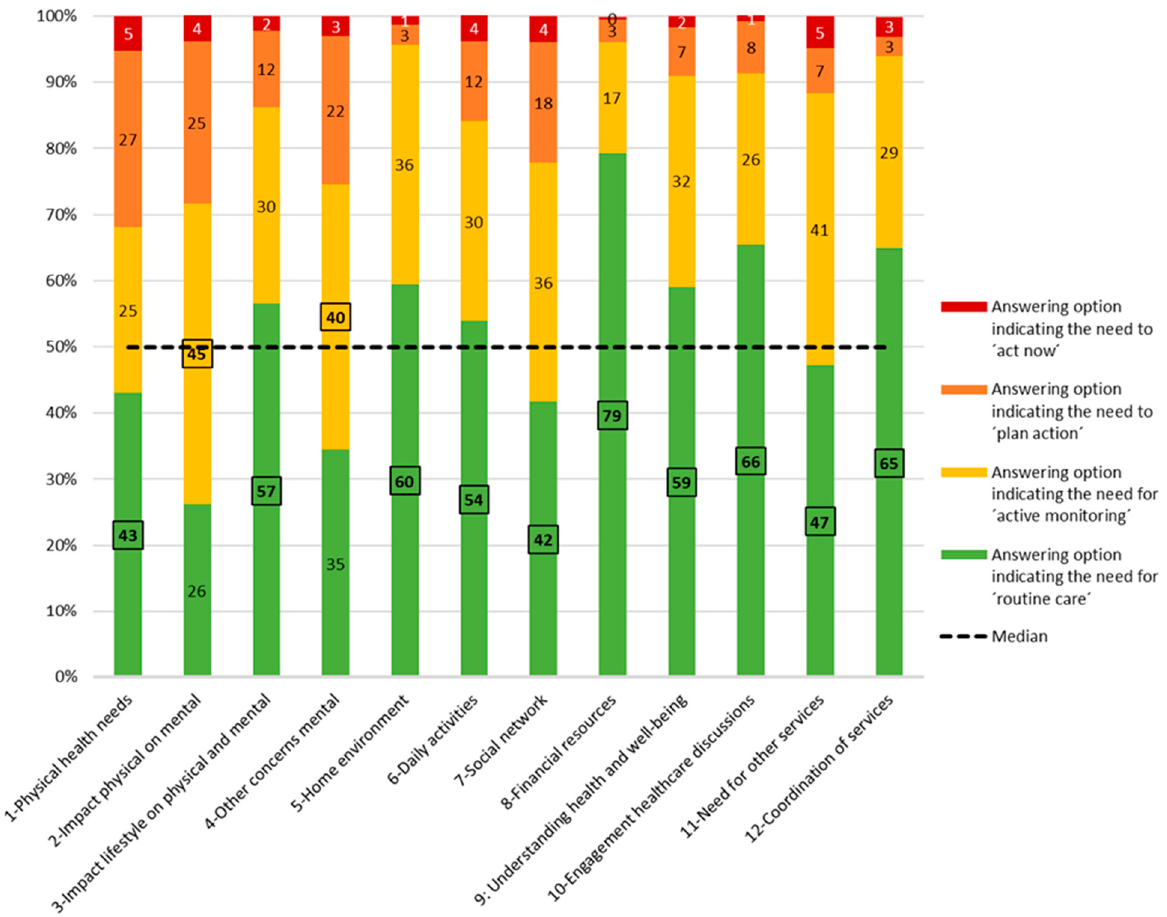
Figure 2. PCAM general properties.